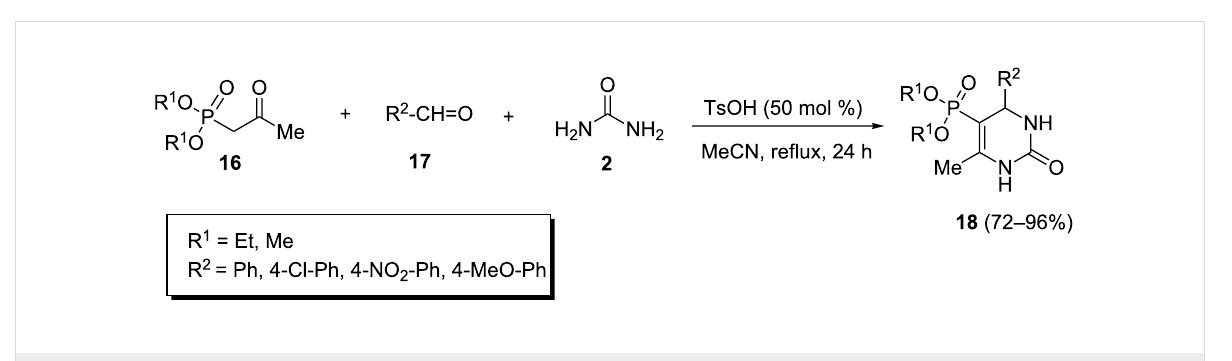
Scheme 5: p -Toluenesulfonic acid-promoted Biginelli reaction of β -ketophosphonates, aryl aldehydes and